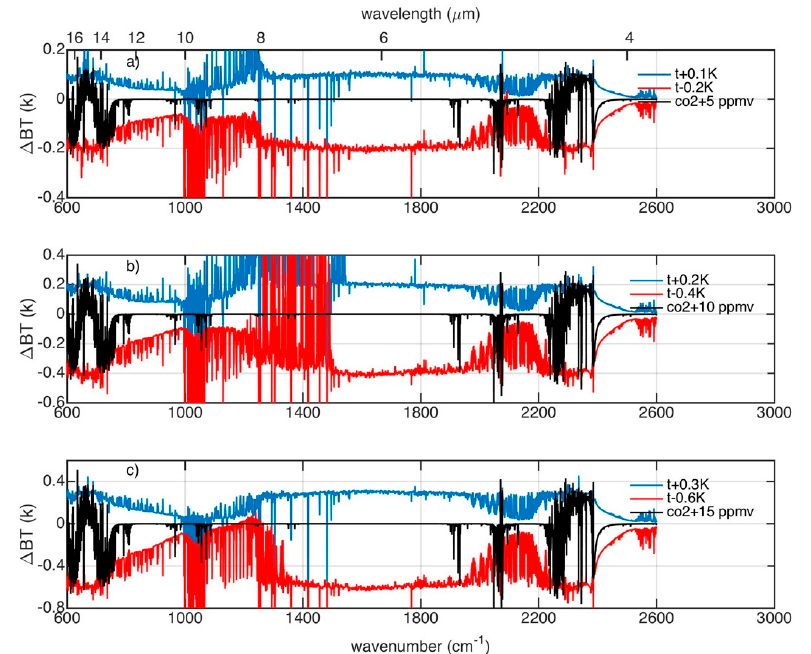
Figure 6. BTD spectra with 0.625 cm − 1 spectral resolution ( a ) when CO 2 concentration profile has an increment of 5 ppmv and atmospheric temperature perturbation with 0.1 K and − 0.2 K; ( b ) when CO 2 concentration profile has an increment of 10 ppmv and atmospheric temperature perturbation with 0.2 K and − 0.4 K; ( c ) when CO 2 concentration profile has an increment of 15 ppmv and atmospheric temperature perturbation with 0.3 K and − 0.6 K.